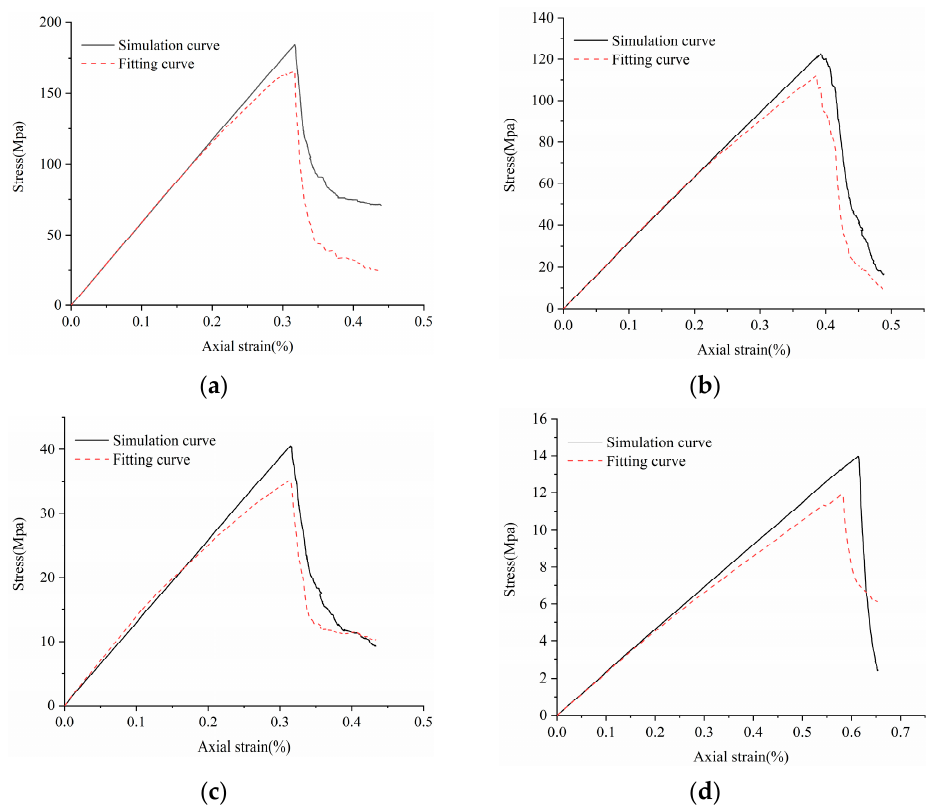
Figure 9. Uniaxial compression damage constitutive equation fitting curve and numerical simulation curve of various rock specimens. ( a ) LdB granite, ( b ) Augig granite, ( c ) TS, and ( d ) coal.